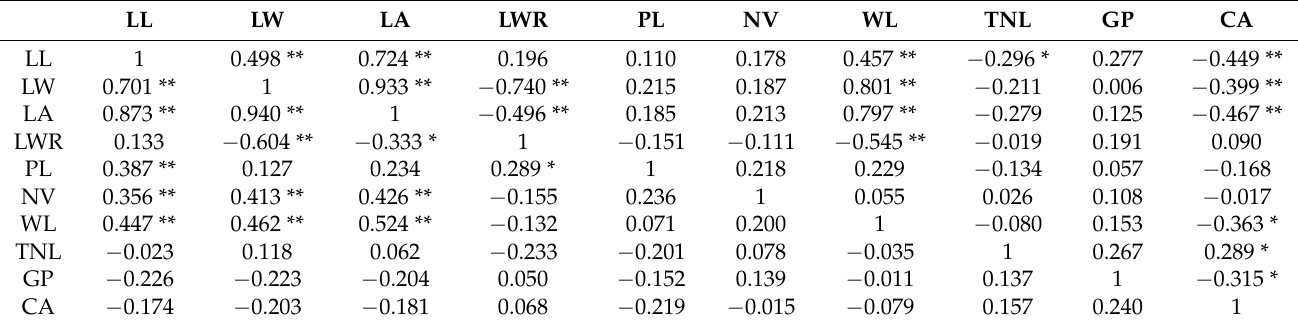
Table 4. Association analyses among leaf-related traits in different planting models of Eucommia ulmoides Oliver. LL LW LA LWR PL